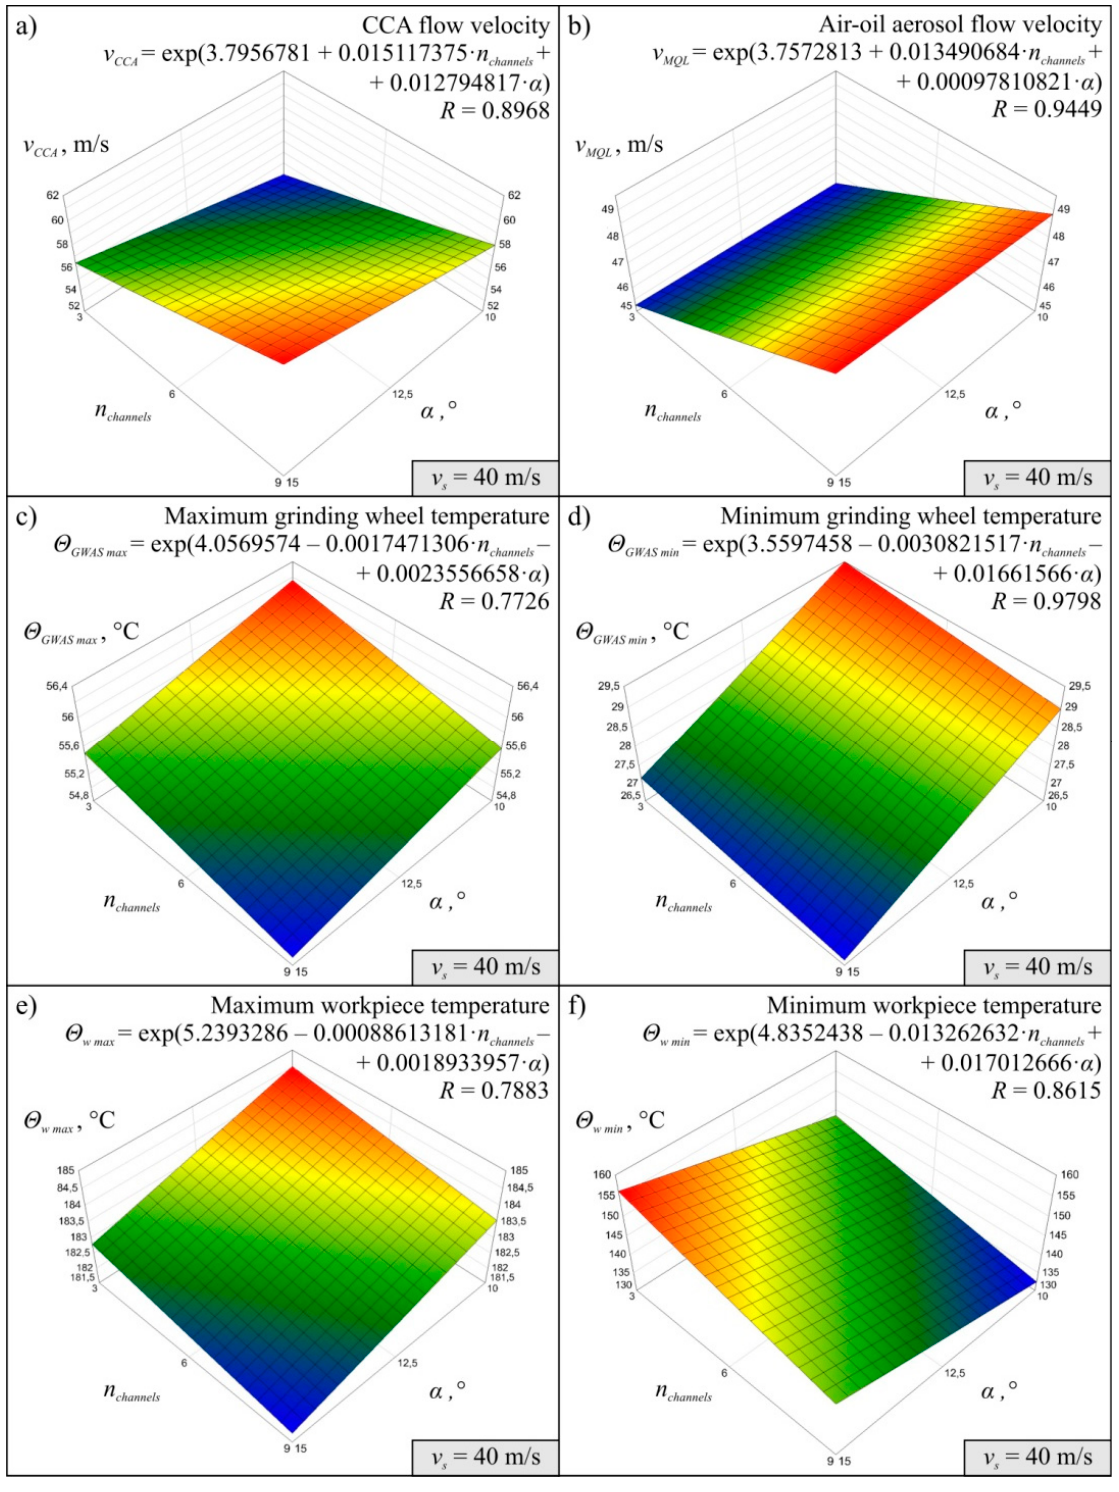
Figure 4. Mathematical models determined on the basis of simulation results for v s = 40 m/s: ( a ) v CCA ; ( b ) v MQL ; ( c ) Θ GWAS max ; ( d ) Θ GWAS min ; ( e ) Θ w max , ( f ) Θ w min.